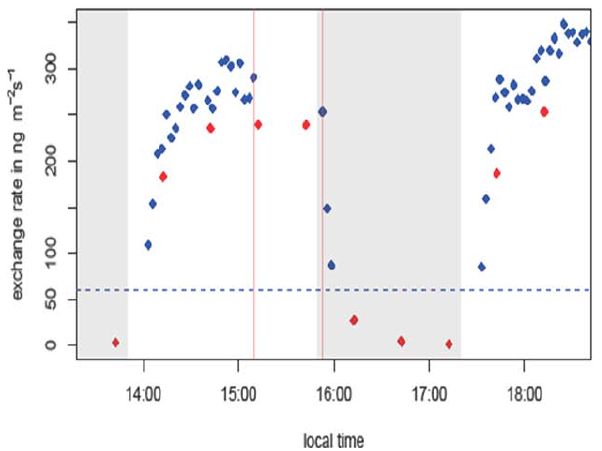
Fig. 10. Limonene calculated gas exchange rates for the zNose data (m), KI 1031 compared to rates obtained by solid sorbent GC- FID data (m). The dashed line indicates the peak detection limit of zNose.